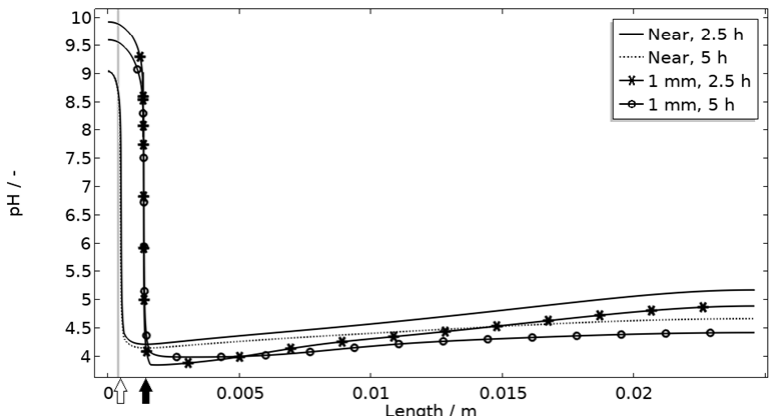
Figure 16. pH along the length of the calibration cell geometry for placement of corroding surface near the stainless steel (at white arrow) or 1 mm from inert region (at black arrow). Exposure with 86 μ g NaCl/cm 2 load at 21 °C and 97% RH. Gray thick line indicates inert region.